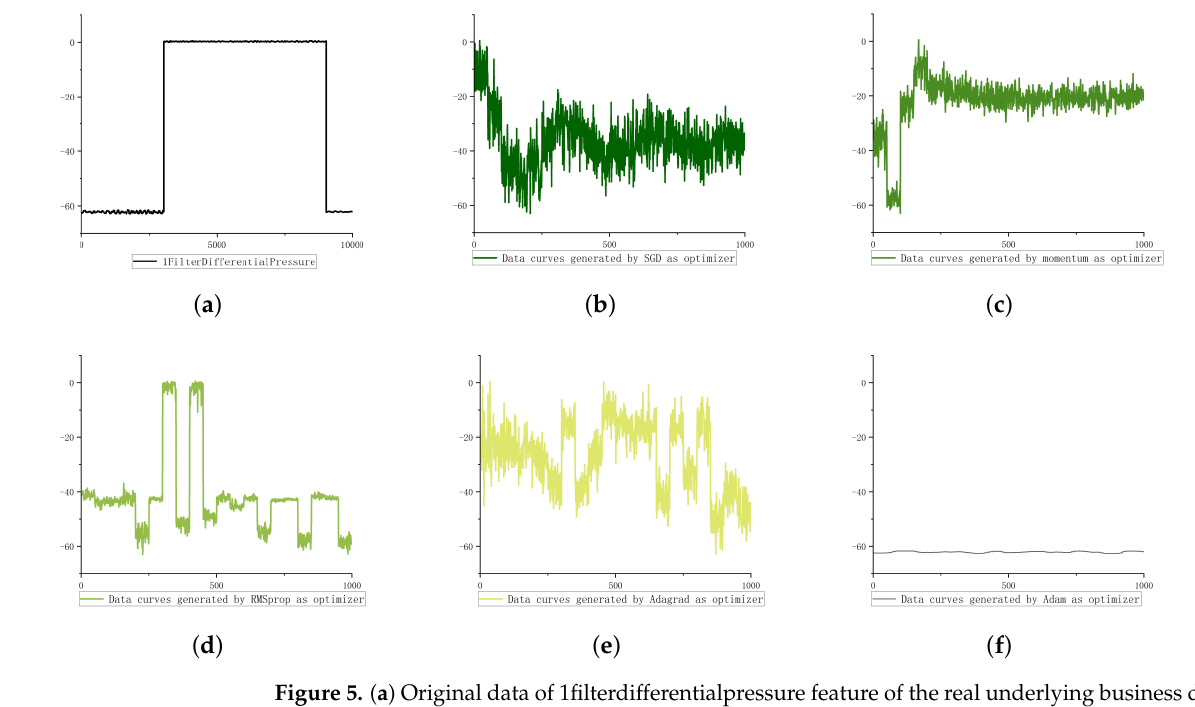
Figure 5. ( a ) Original data of 1filterdifferentialpressure feature of the real underlying business dataset of the oil depot; ( b ) SGD is selected as the generation result of the optimizer; ( c ) momentum is selected as the generation result of the optimizer; ( d ) RMSprop is selected as the generation result of the optimizer; ( e ) Adagrad is selected as the generation result of the optimizer; ( f ) Adam is selected as the generation result of the optimizer.